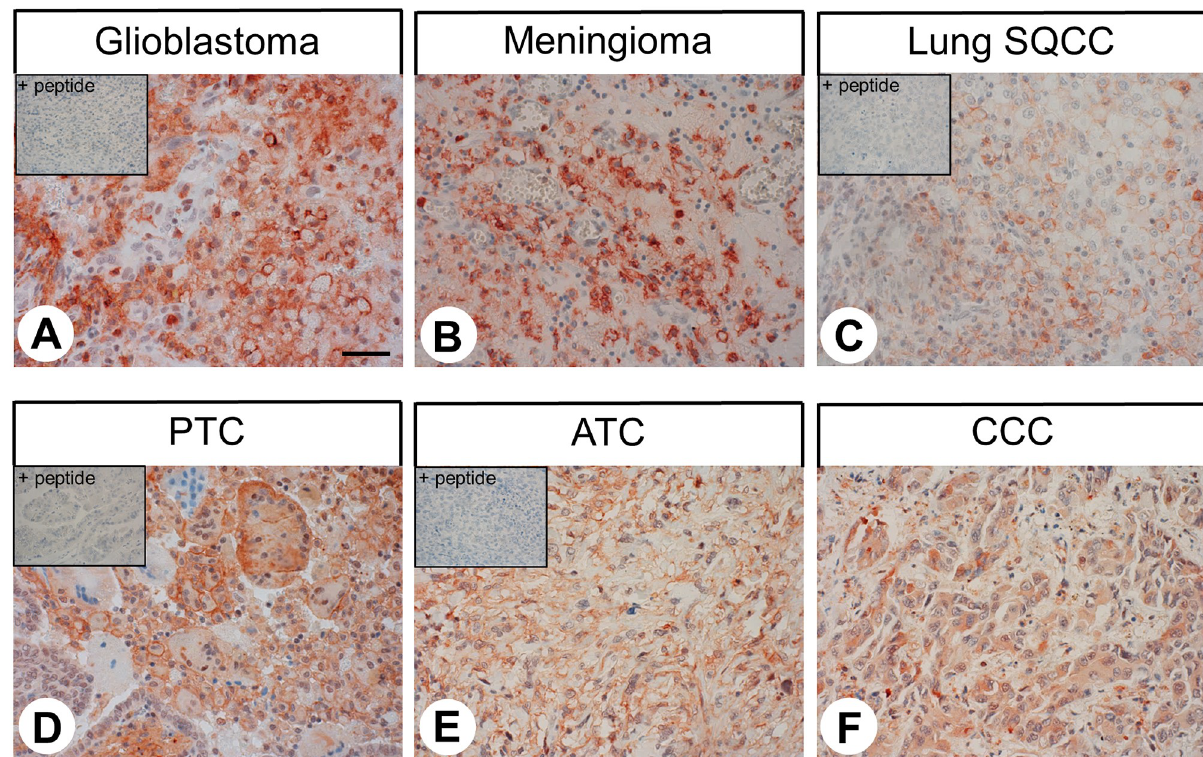
Fig 5. Immunohistochemical detection of C5aR1 localisation in human tumour entities (I). Immunohistochemical staining (red-brown colour), counterstaining with haematoxylin. Scale bar: 50 μ m (A-F). Insets in (A, C, D, E): for adsorption control, the anti-C5aR1 antibody {5227} was incubated with 10 μ g/ml of the peptide used for immunisations. Lung SQCC: squamous cell carcinoma of the lung; PTC: papillary thyroid carcinoma; ATC: anaplastic thyroid carcinoma; CCC: cholangiocellular carcinoma.